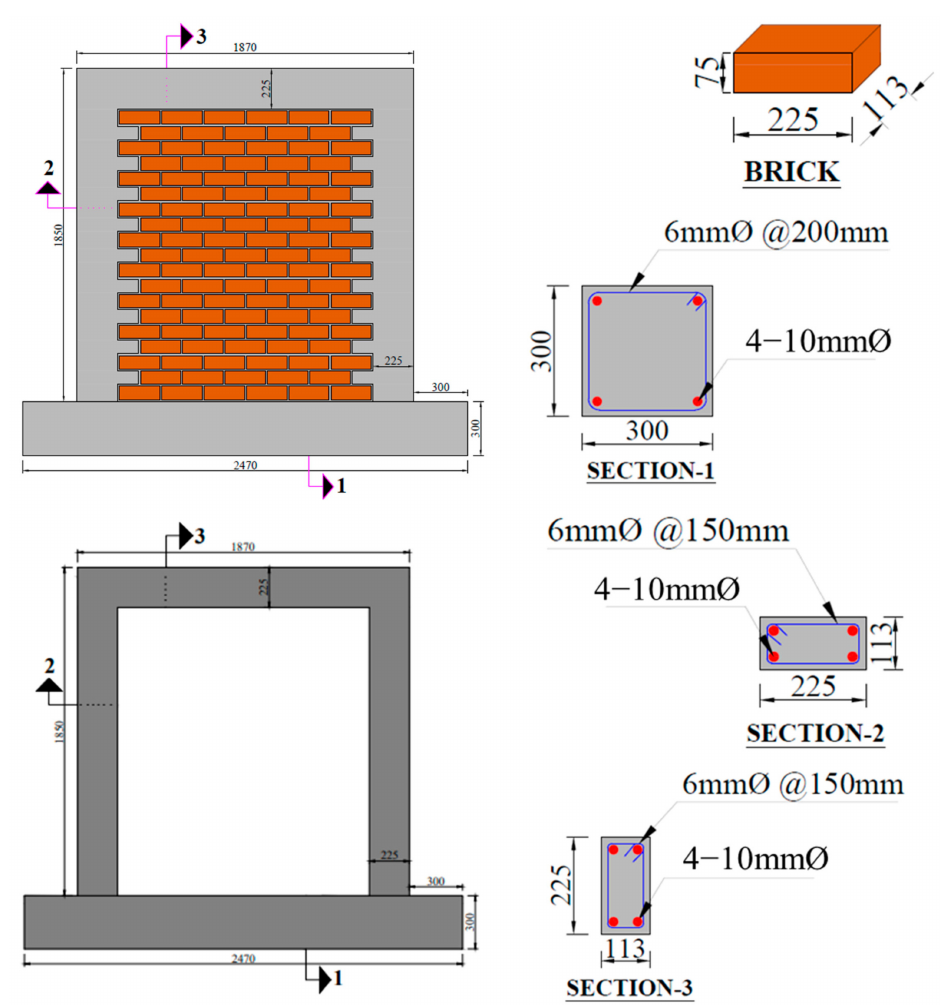
Figure 1. Schematics and reinforcement detailing of bare frame and confined masonry